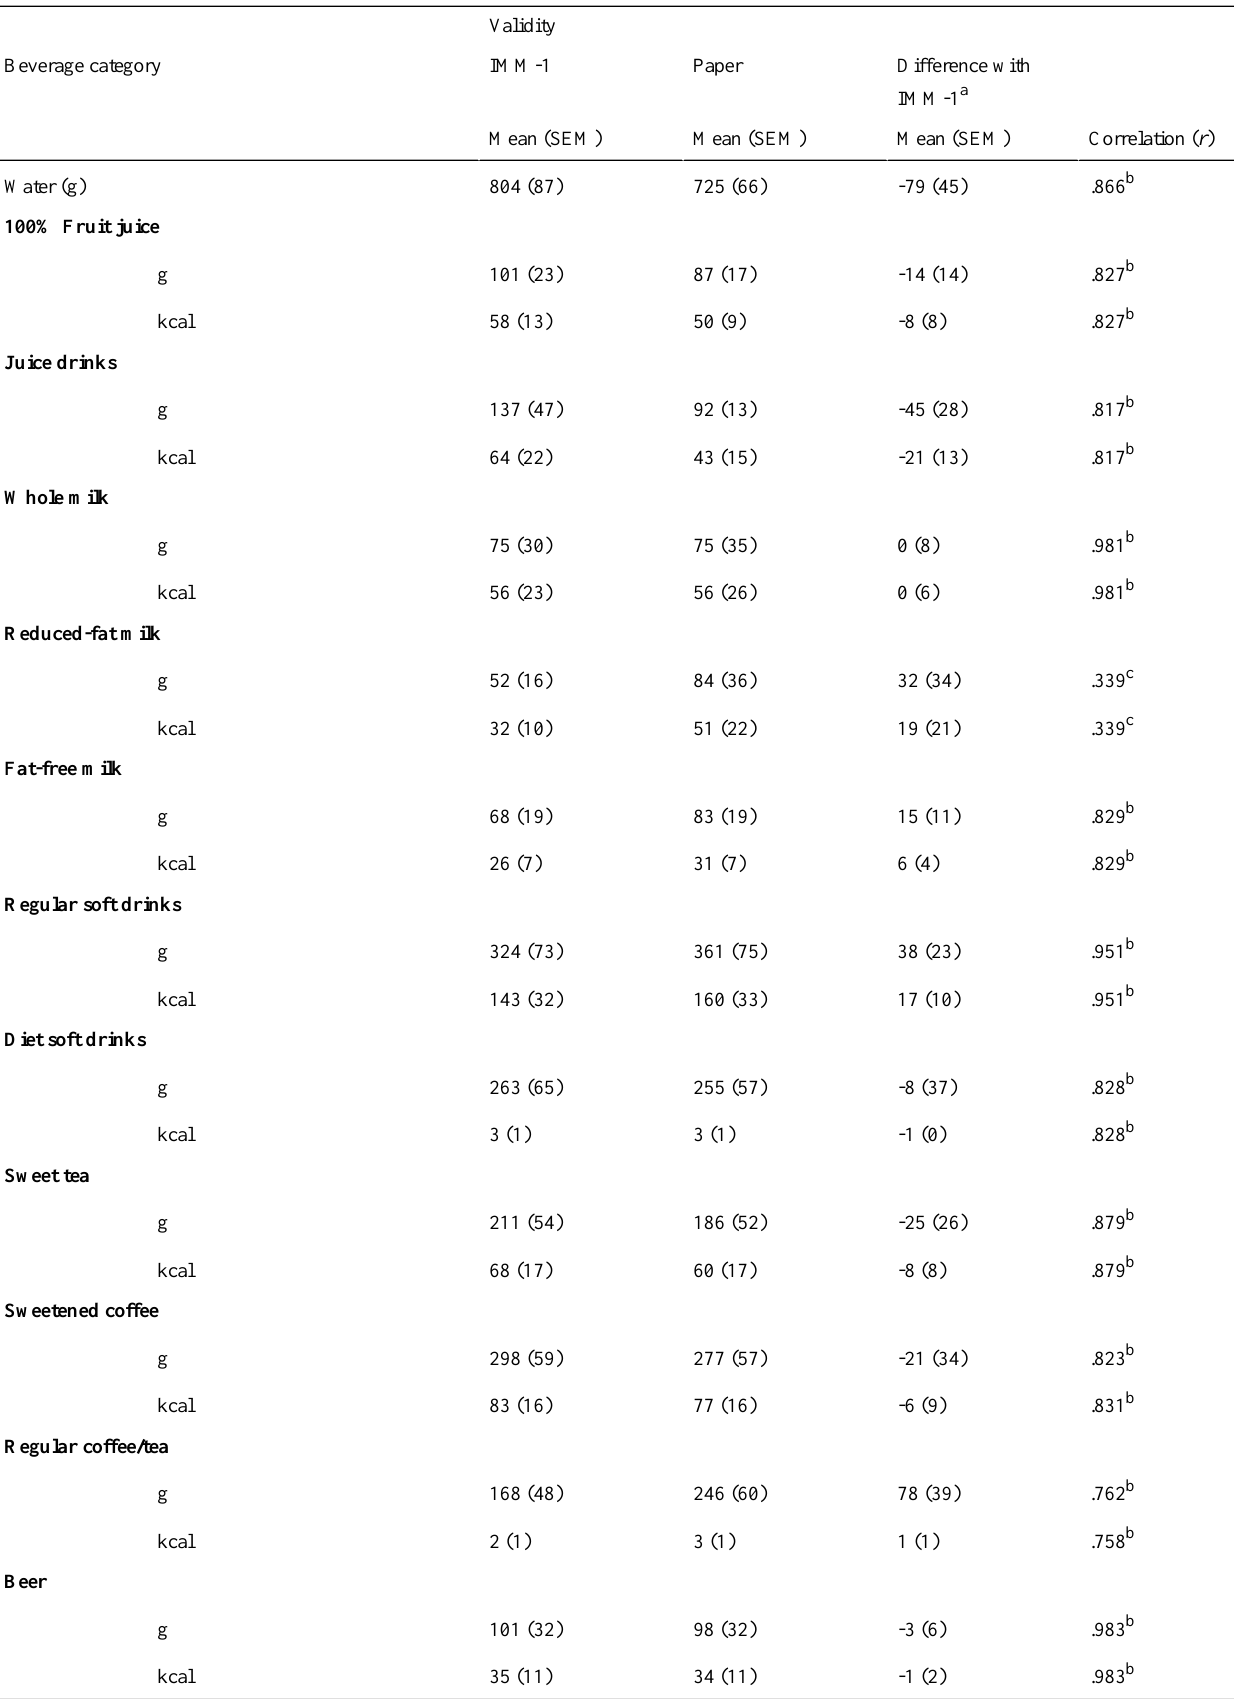
Table 2. Comparative validity of the IMM BEVQ-15: a comparison of the individual beverage category responses from the first IMM administration to the PP